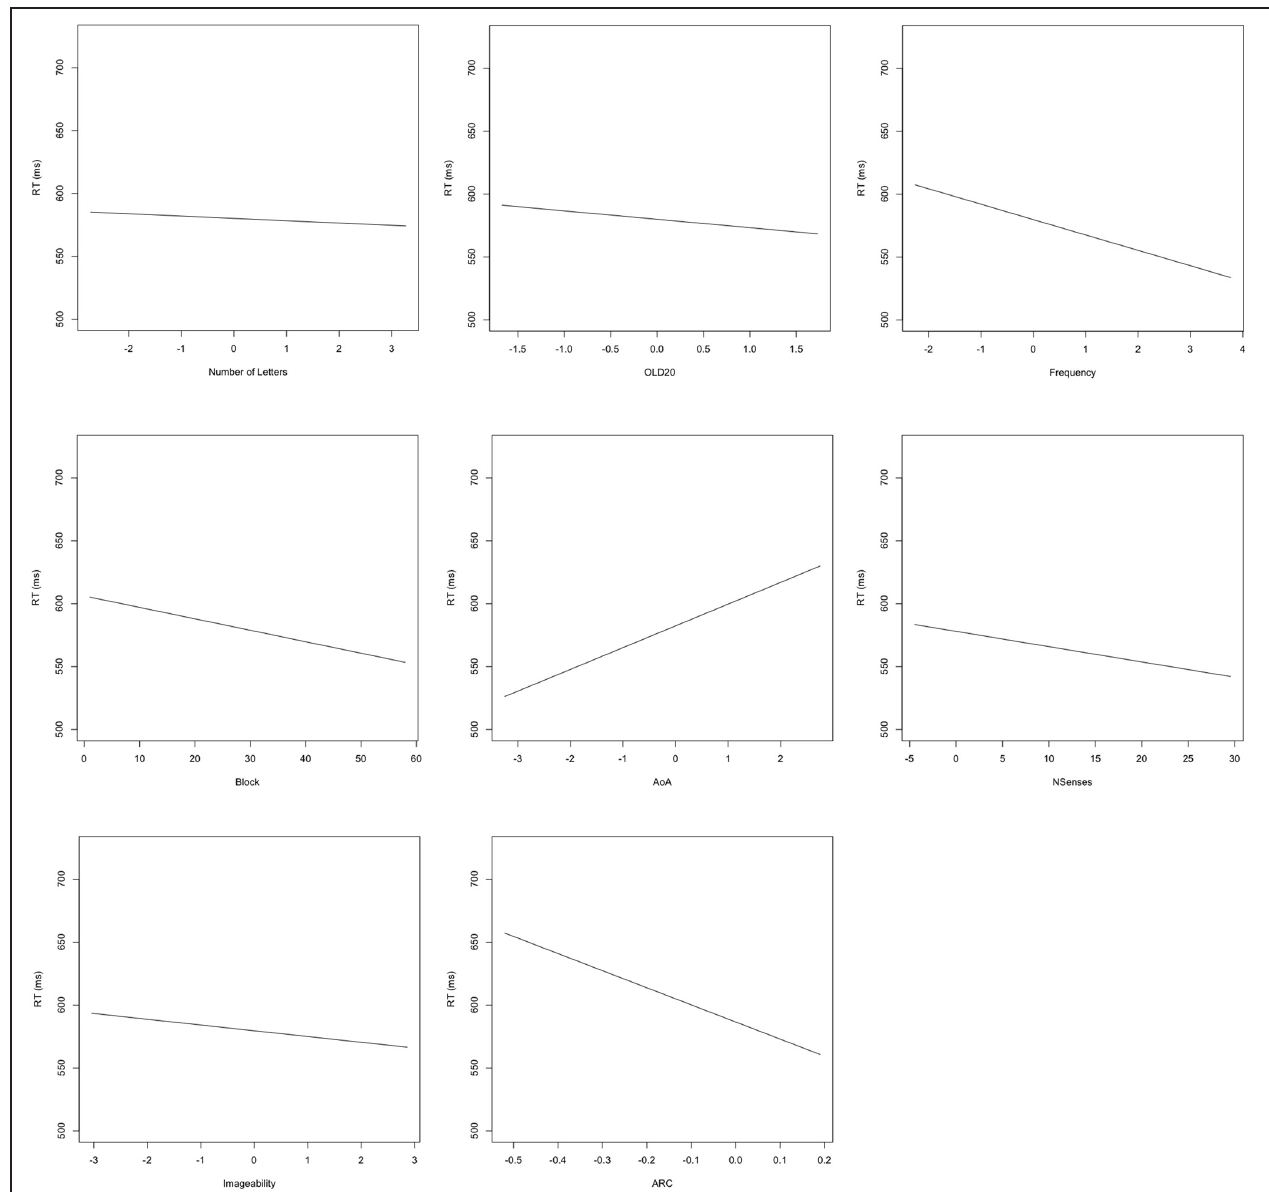
FIGURE 2 | Plots of fixed effects from a model fitted to LDT reaction times to 3723 words. Note: Length, number of letters (centered); OLD20, mean levenshtein distance to nearest 20 orthographic neighbors (centered);